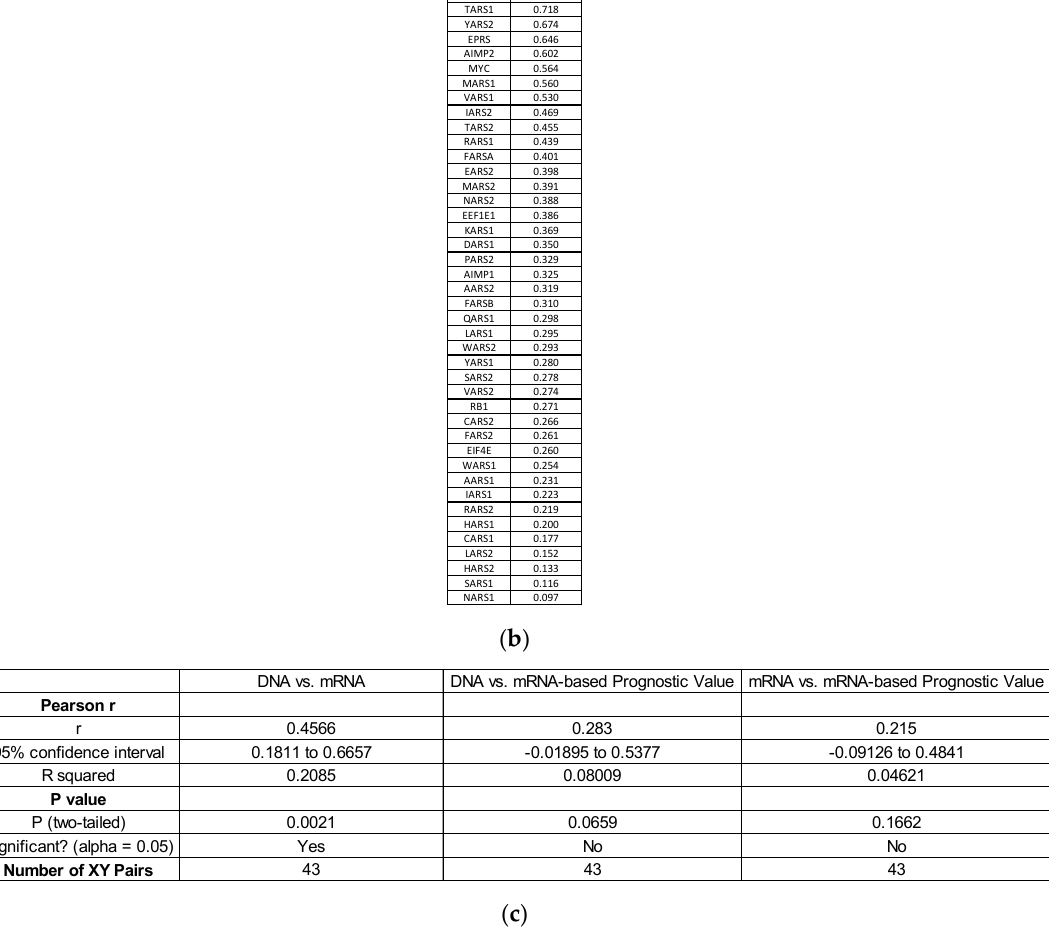
Figure 5. Normalization and comparison of CNV, mRNA expression, and survival scores. ( a ) The major results from the previous figures were summarized by assigning a normalized score to each. For CNVs, the GISTIC2 scores for each gene were averaged across all cancer types. For mRNA expression, the number of cancers di ff erentially downregulating each gene was subtracted from the number of cancers di ff erentially upregulating the gene. For survival, the number of cancers with a significantly low HR was subtracted from the number with a significantly high HR. ( b ) All values were then normalized between 0 and 1 and then averaged for each gene, allowing the genes to be ranked in order. ( c ) Correlation analysis was performed between each of the three columns (DNA, mRNA, mRNA-based prognostic value) by calculating Pearson correlation coe ffi cients (two-tailed, p < 0.05).